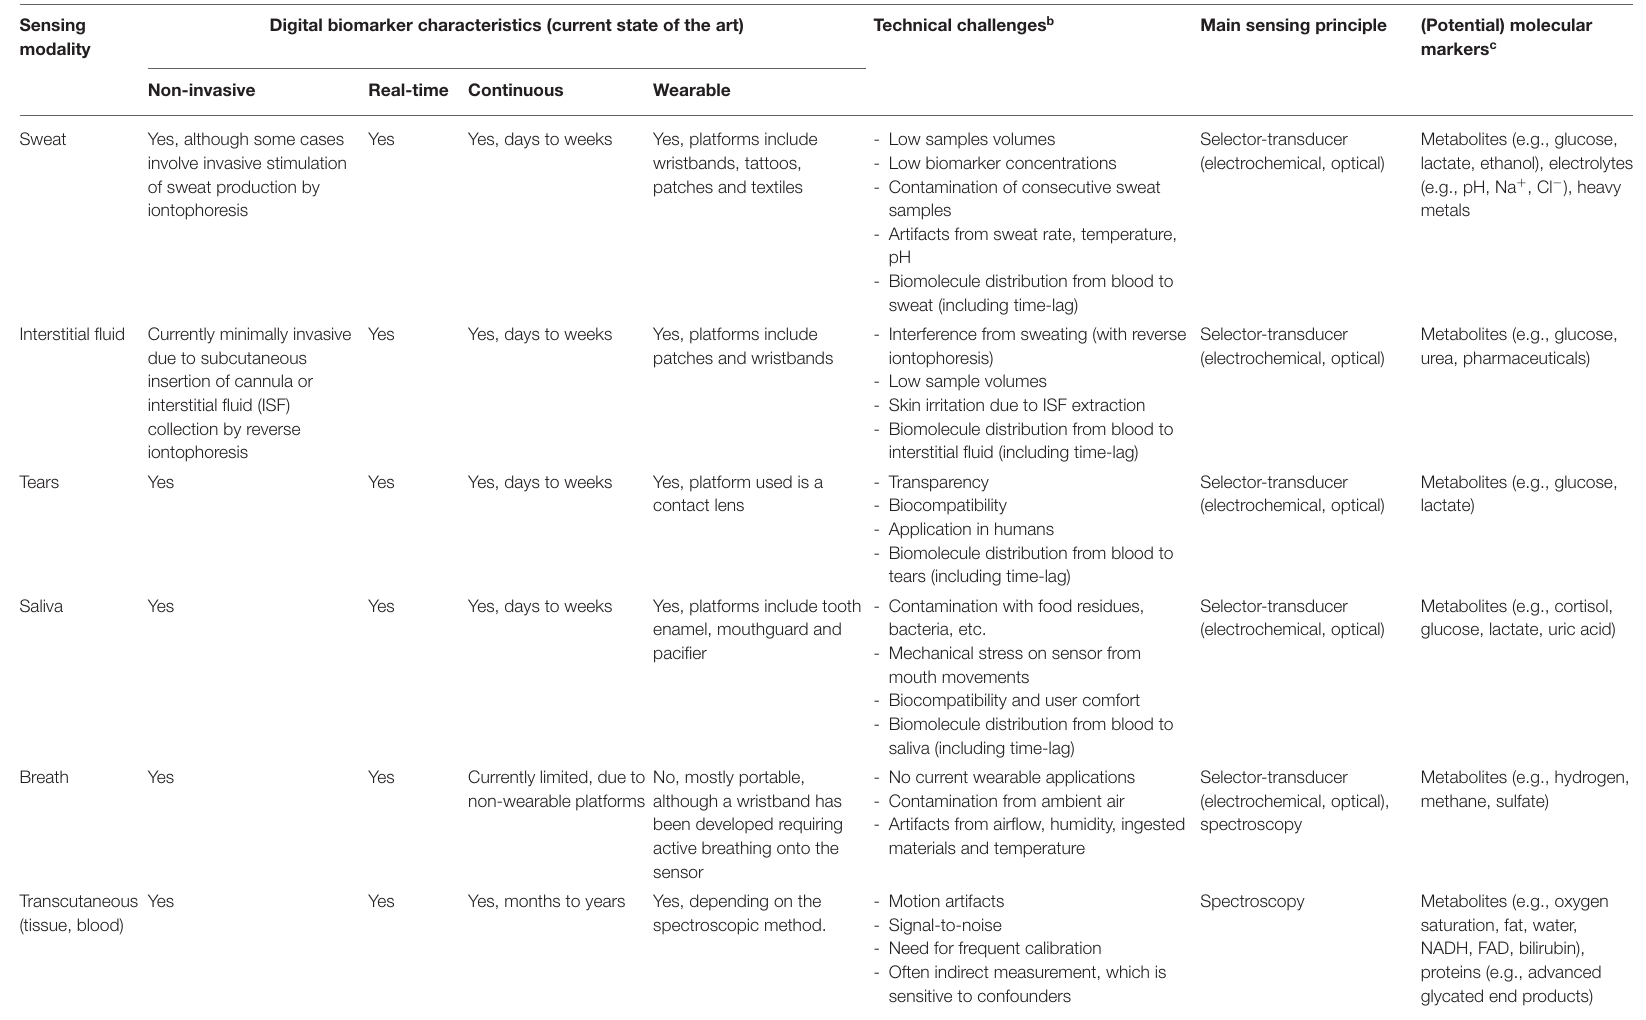
TABLE 2 | Digital biomarker characteristics, challenges and sensing principles of molecular digital biomarkers in non-invasive biofluids a . Sensing